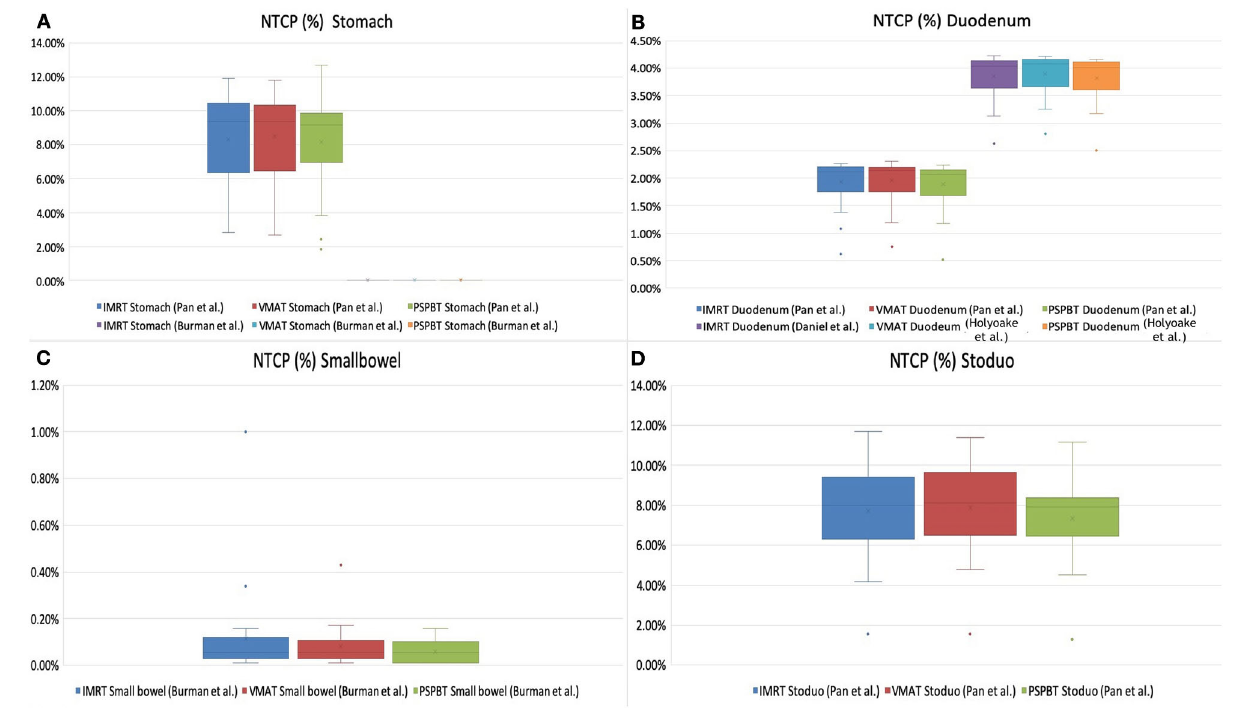
ulceration/perforation and small bowel obstruction/perforation ( 1 NTCP IMRT PSPBT and 1 NTCP VMAT PSPBT ) was minimal for − − endpoints were lower, and similar values were predicted for all the upper GI bleeding, ulceration, obstruction, and perforation techniques ( Table 4 and Figures 4A,C toxicity endpoints ( Table 4 ). The NTCP values for the gastric